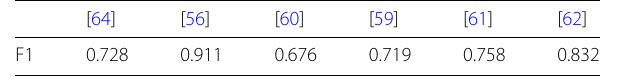
Table 6 Comparative results of different approaches in terms of F1-score on the VMU2016